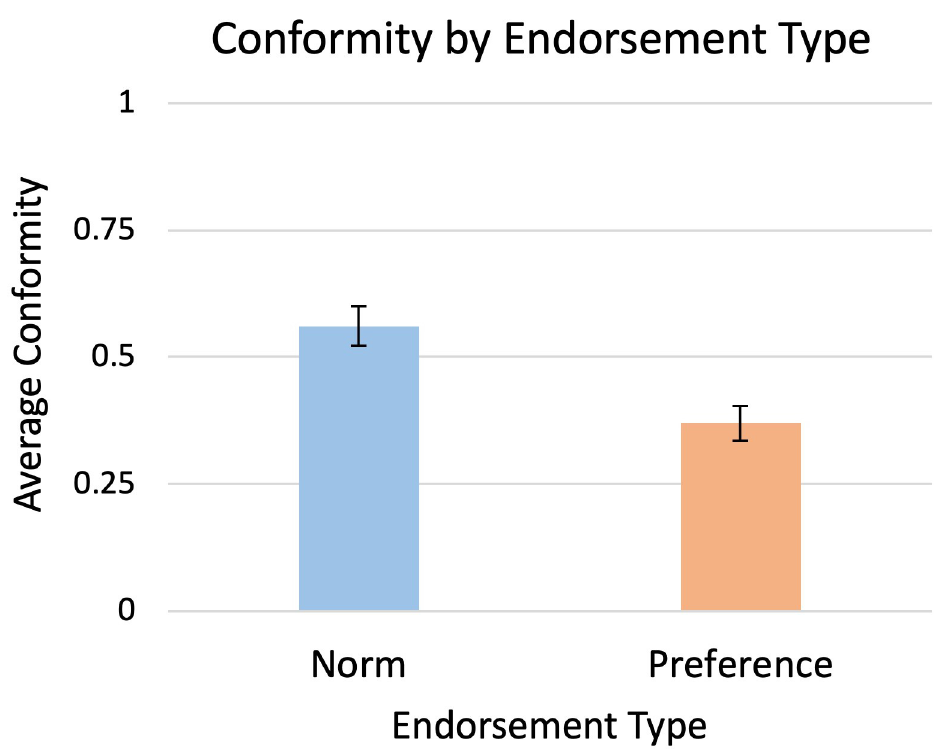
Fig 1. Children conformed more to norms than to preferences. Error bars represent standard errors. Note that the full range of conformity scores (y-axis) is from 0 to 2, although only the range from 0 to 1 is depicted here.